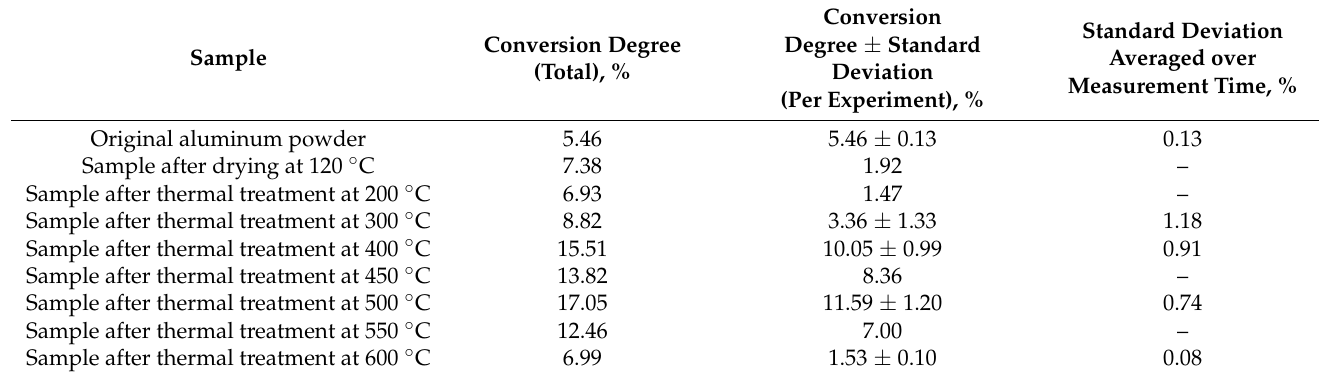
Table 2. Aluminum conversion degrees (hydrogen yields) for different samples.